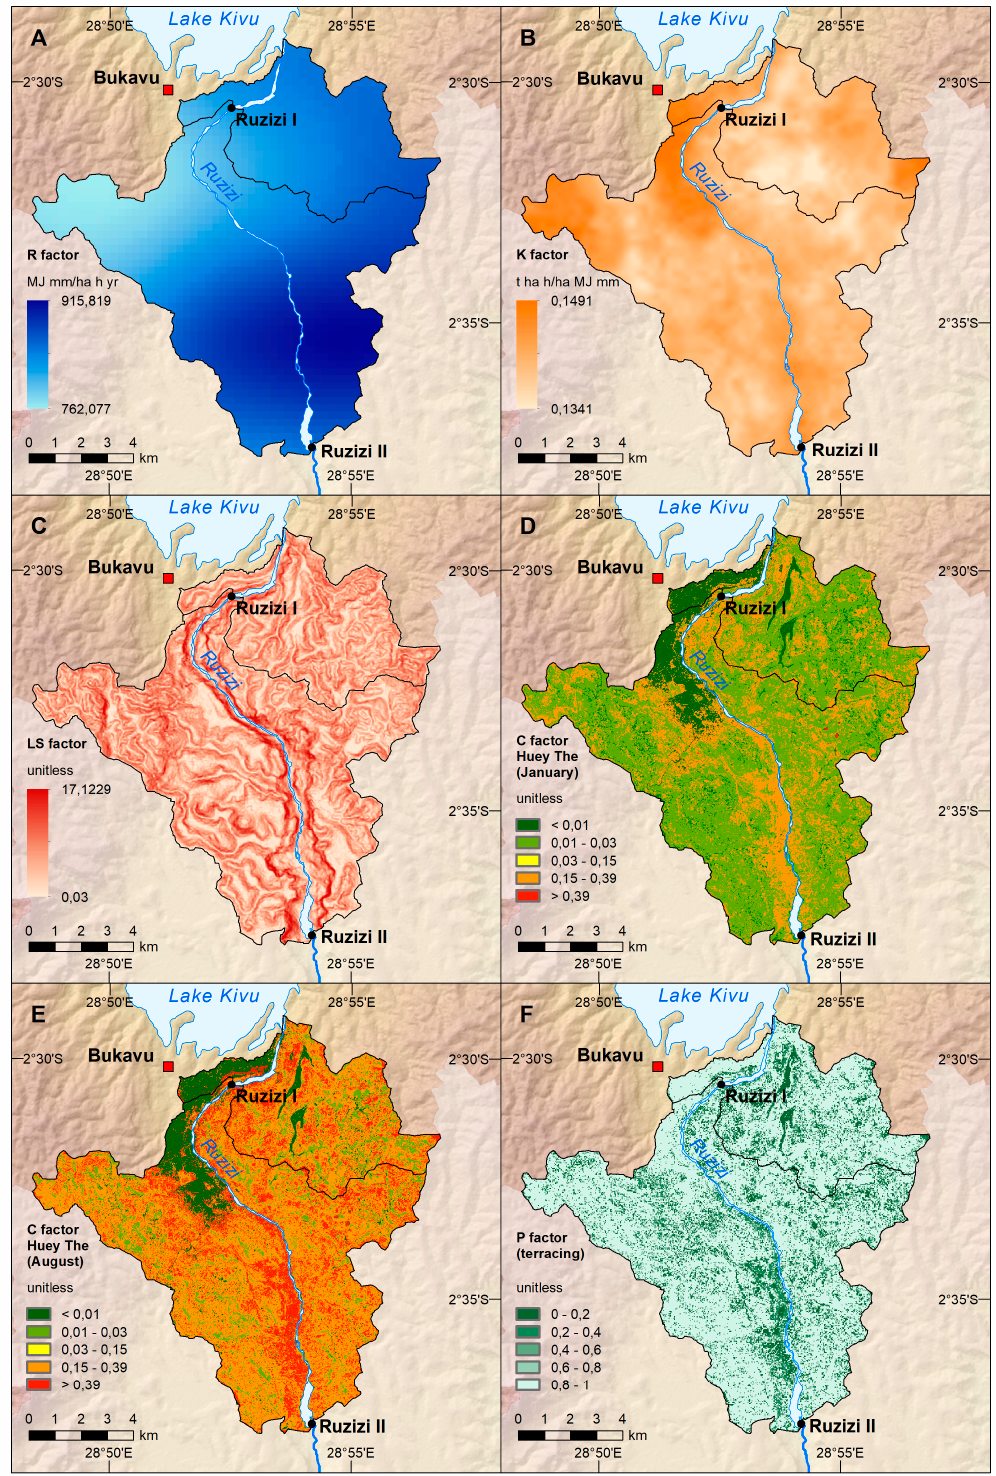
Figure 2. Resulting maps of the single factors for RUSLE calculations; ( A ) mean R factor calculated after Prasannakumar et al. [15]; ( B ) K factor calculated after Karamage et al. [16]; ( C ) LS factor calculated after Karamage et al. [16]; C factor calculated using the definitions of Malaysian Department of Agriculture (2010, cited from [23]) for rainy ( D ) and dry seasons ( E ); ( F ) P factor [49].